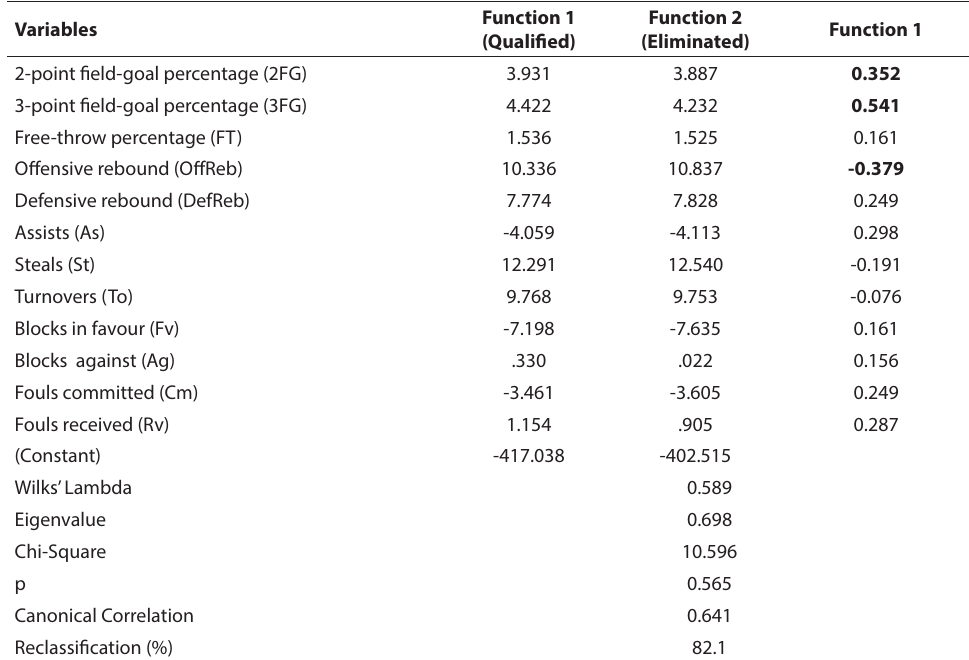
TABLE 4 Discriminant analysis results for the fi nal four Discriminant Function Coeffi